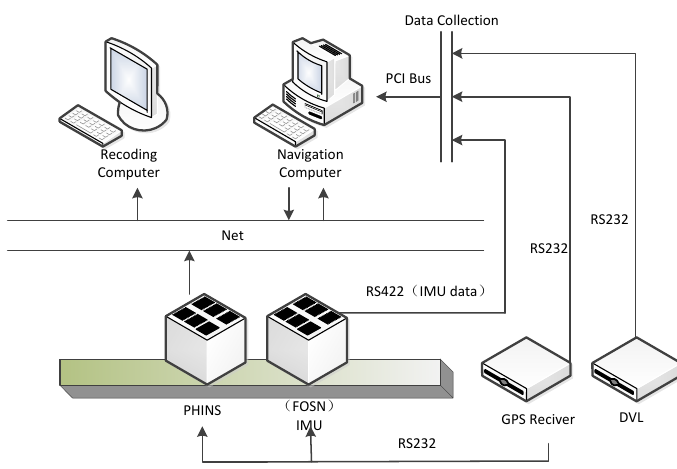
Figure 4. Structure diagram of alignment experiment based on vehicle.